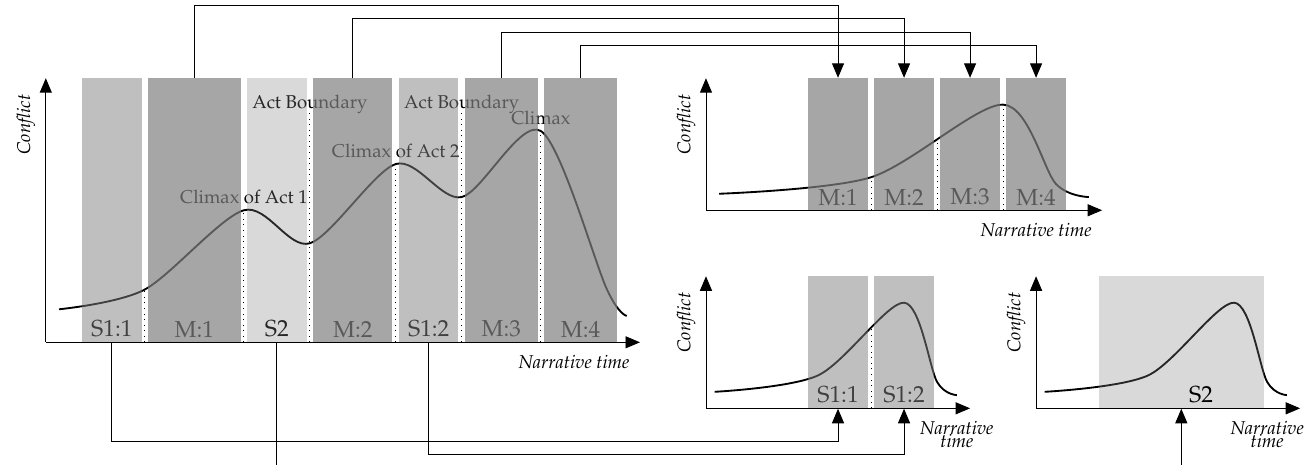
Figure 1. An example of plot structure decomposition. The left chart describes a plot structure of a story that is interwoven with one main plot (M) and two subplots (S1 and S2). Fragments of the main plot and subplots are alternately presented to escalate conflicts around the protagonist and maintain users’ interest [17]; M: n indicates the n -th fragment of M. This study aims to decompose the plot structure and rearrange the fragments into individual story lines, as shown in the right three charts. Y-axis of the charts indicate intensities of conflicts in the story. We infer the intensity from changes in fictional characters’ personalities rather than quantify conflicts